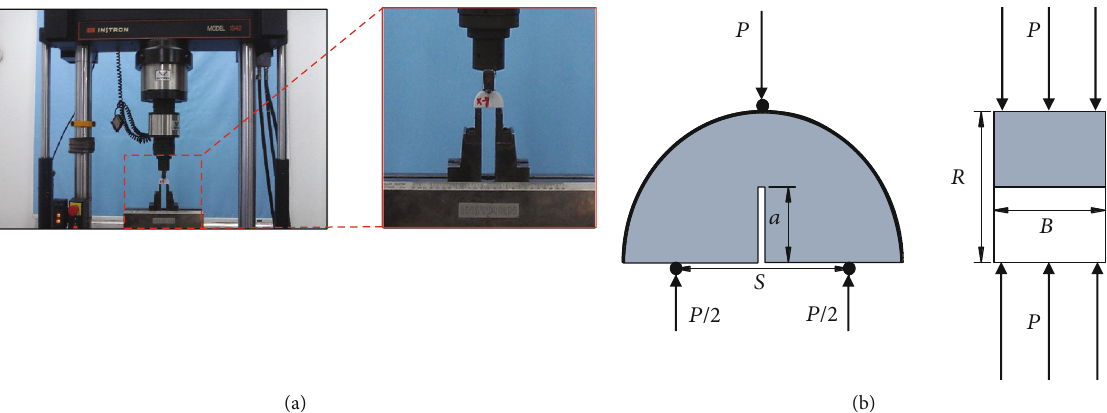
Figure 2: (a) INSTRON testing system and (b) SCB specimen geometry and schematic loading arrangement.